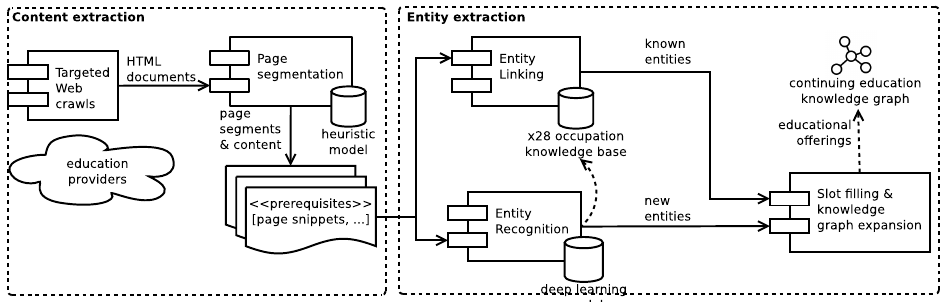
Figure 2. Overview of the automatic knowledge graph construction